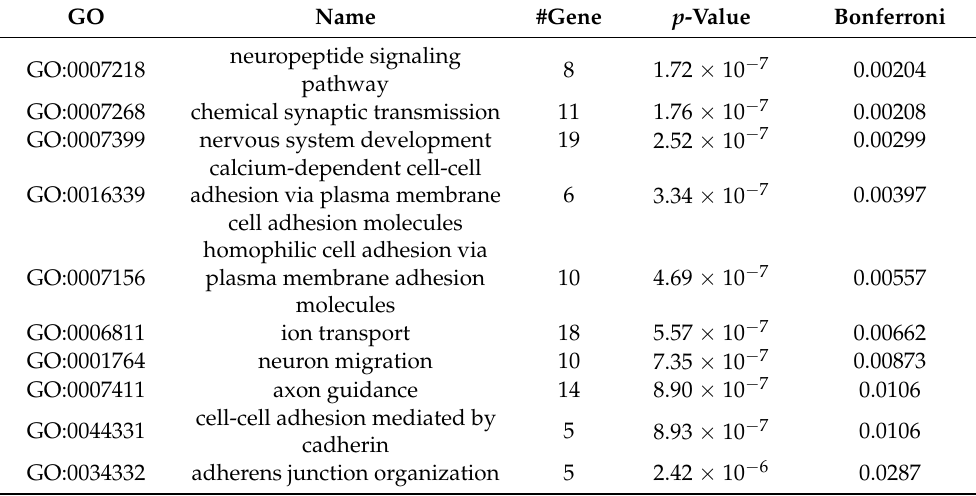
Figure 1. Global gene expression. Gene expression differences between young and old mice. X -axes means the mean expression of genes in young and old group. Y -axes means the log2FC of the gene expression difference between old and young group. Table 1. Top 10 GO terms enriched by